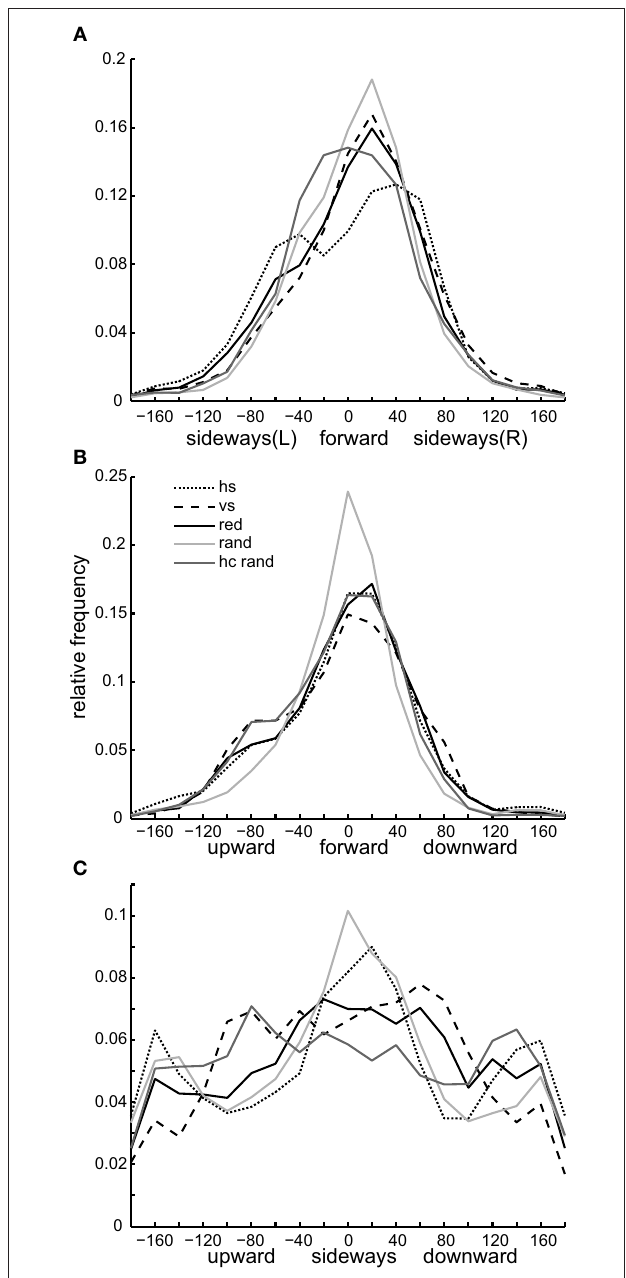
Figure 8 | Flight velocity combinations close to the labeled landmarks. To compare flight velocity combinations for different landmark textures (for glossary and numbers see Figure 6 ), we calculated the angle of the sideways/forward (A) , lift/forward (B) and lift/side velocity vectors (C) for those parts of the flight trace where the bee was closer than 100 mm to the center of the labeled landmark at each point of time. The histograms show the relative frequency for the different flight velocity combinations (bin size of 20 ° ). An angle of zero degrees means that the bee is flying only forward in (A) and (B) or sideways [to the right in (C) ] without any sideways (A) or lift component (B,C) . An angle of ± 90 ° indicates that the bee is flying sideways [to the right (R) or to the left (L)] without any forward component in (A) , or only up- and downwards without any forward in (B) or sideways velocity component in (C) . The amount of time honeybees fly in different velocity combinations depends on the kind of